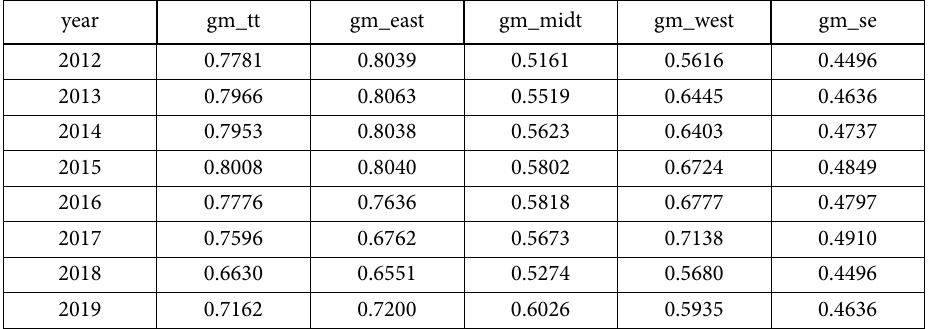
Table 4. The variation coefficient of the urban resilience in